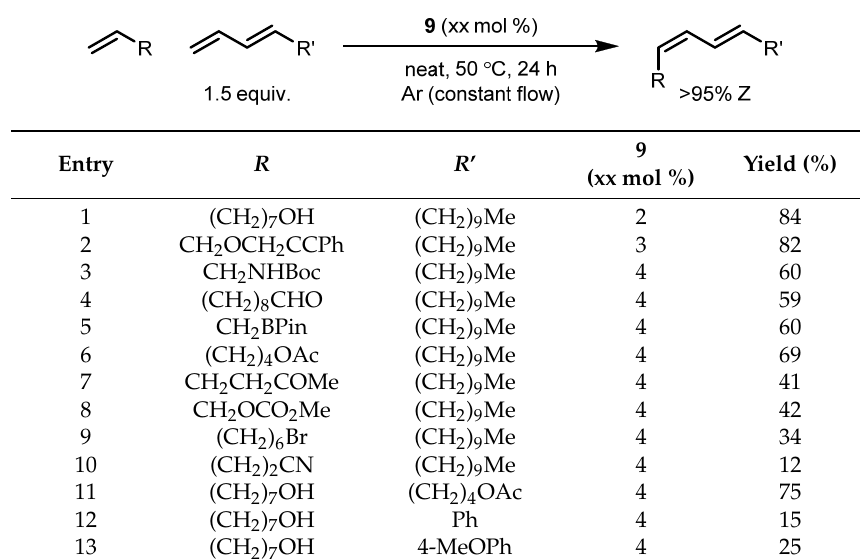
Table 8. Z -Selective CM of 3 E -1,3-dienes with terminal olefins.